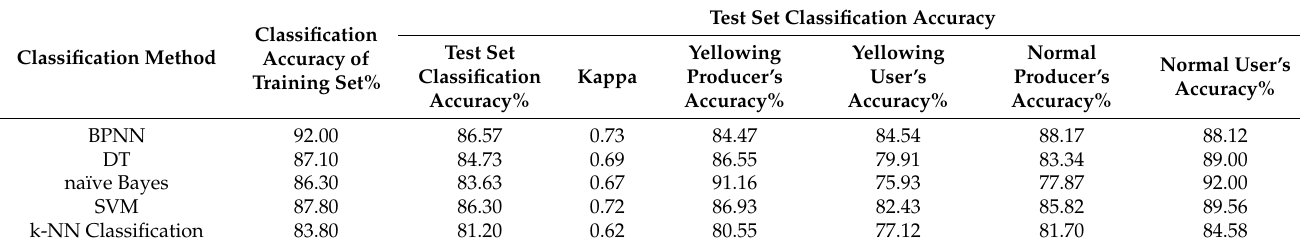
Table 2. Classification accuracy of different machine learning